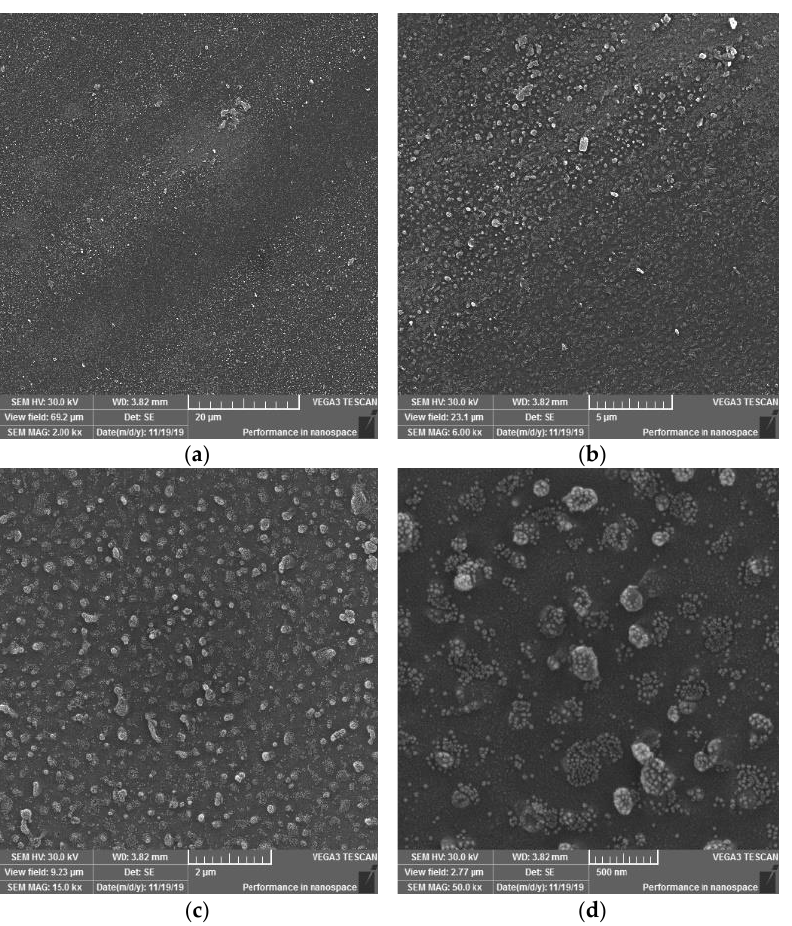
Figure 14. SEM morphology of the surface of plasma modified PVC exposure type III. Observed magnifications: 2000× ( a ), 6000× ( b ), 15,000× ( c ), 50,000× ( d ).